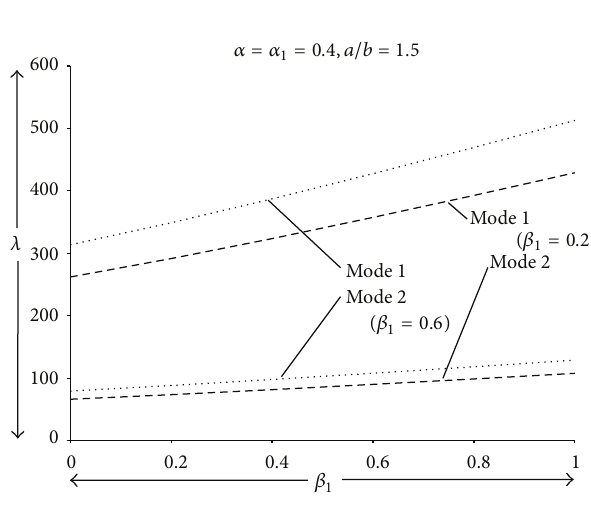
Figure 3: Frequency versus taper constant ( 𝛽 2 ).